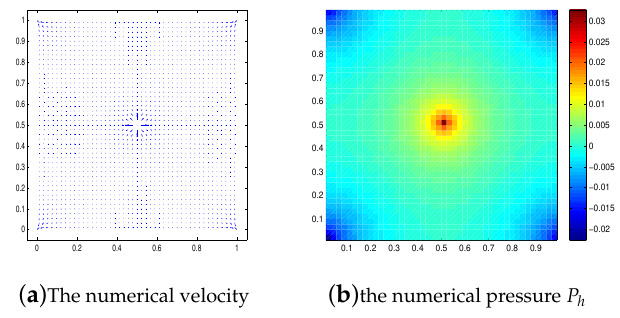
Figure 3. The numerical velocity and pressure solution in five-spot pattern.